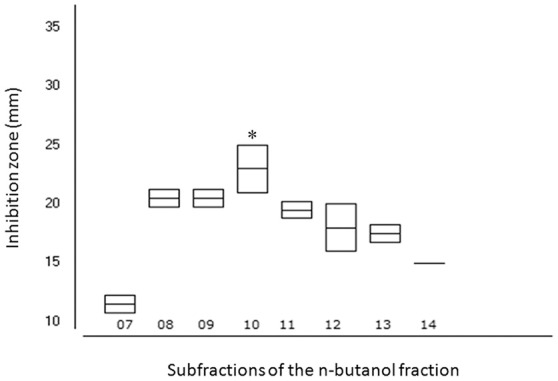
Boxplots of the mean values and standard deviations of the sizes of the inhibition zones caused by activity of specific FBuOH sub-fractions (SF 7–14). ANOVA and Tukey's test (p < 0.001) showed that the SF10-FBuOH had a significant greater inhibition zone size than the other sub-fractions tested (*p < 0.05).